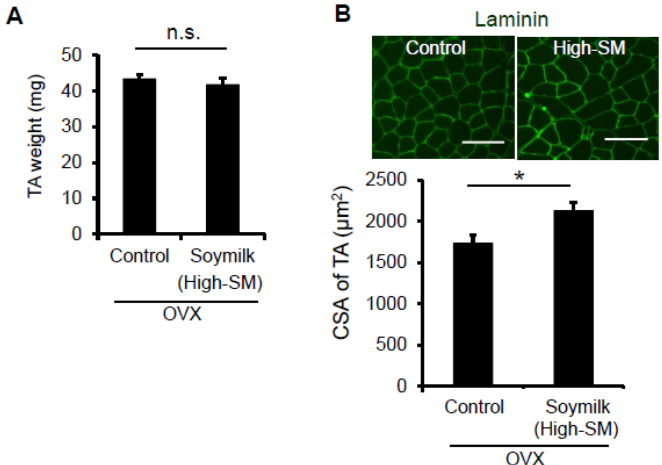
Figure 4. Effect of High-SM intake on muscle in OVX mice. OVX mice were fed with High-SM soymilk intake. ( B ) Representative images of immunohistochemistry for laminin. CSA of TA muscle